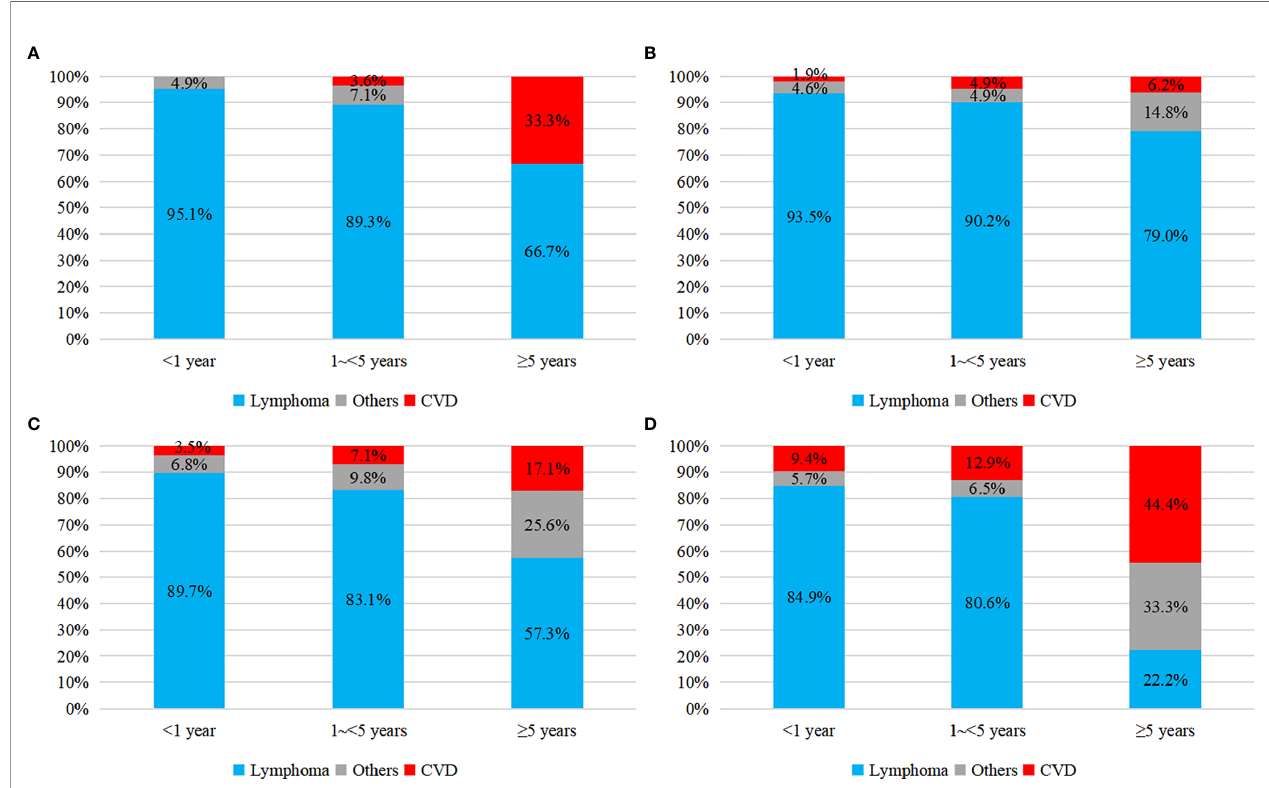
FIGURE 5 | Proportion of all causes of death in PCNSLs by different survival time. (A) age at 20~39, (B) age at 40~59, (C) age at 60~79, (D) age at 80+.